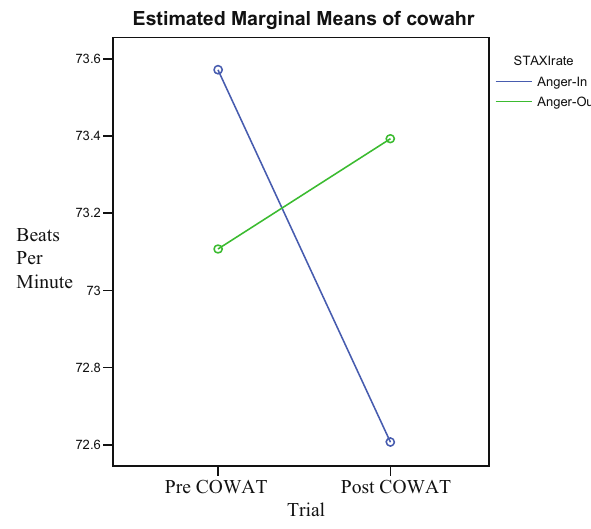
Fig. 3 COWAT heart rate, group by time